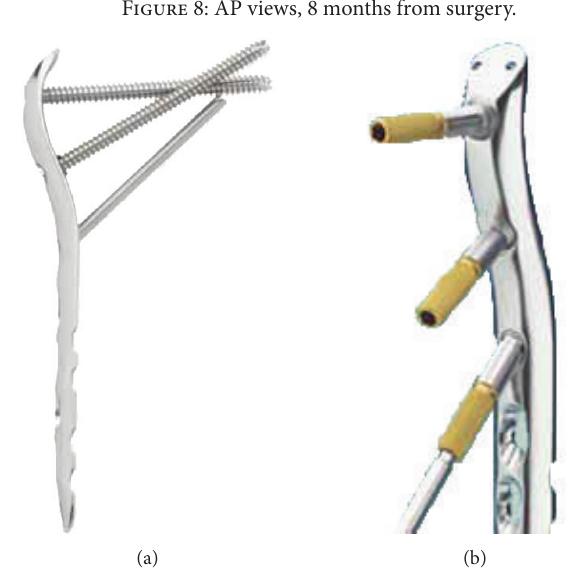
Figure 9: Positions of the screw holes with drill